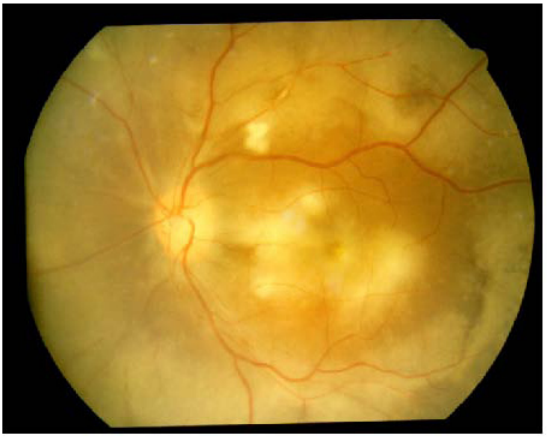
Figure 4 Progressive outer retinal necrosis (Photo courtesy of Dr Linda Visser) Syphilitic